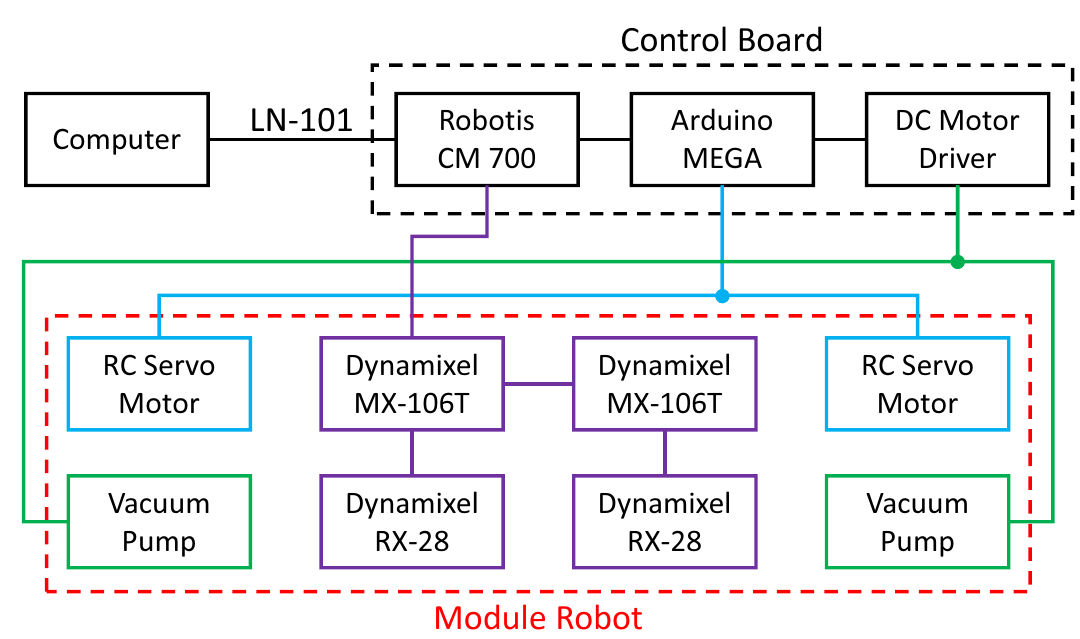
Figure 13. A system architecture for the experiments. The system mainly consists of a laptop computer for the target position indication, the biped robot, and a control board. Since the biped robot is suspended on a rope for safety purposes, the control board and power supplies such as the safety rope can be installed